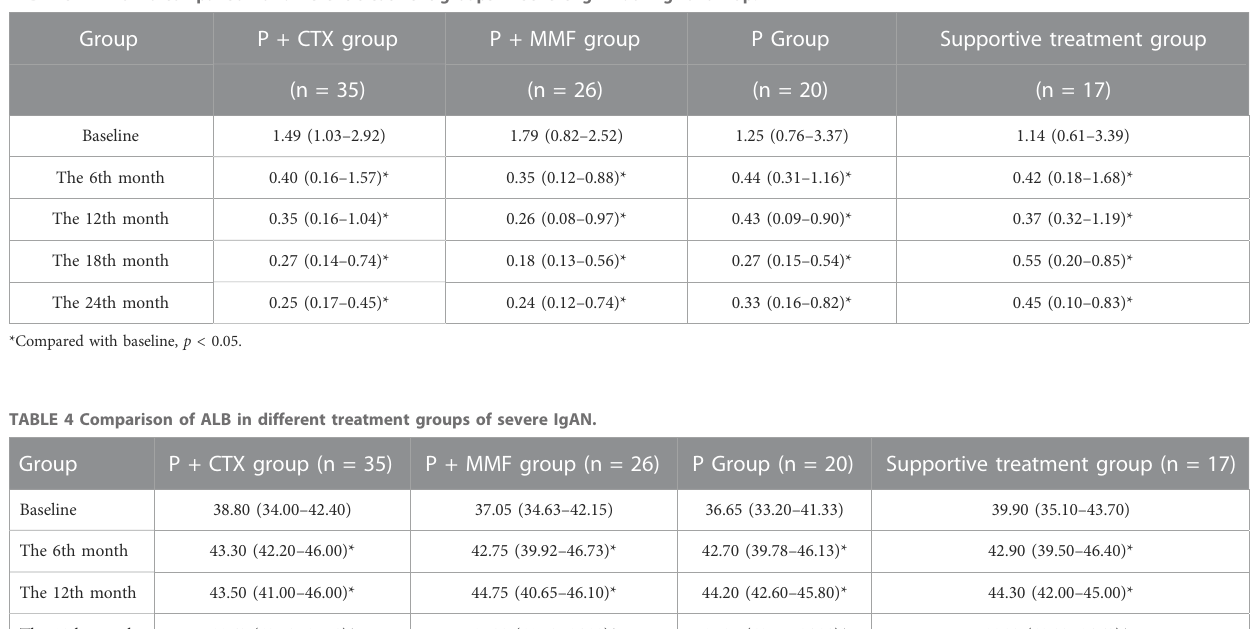
TABLE 3 24 h-UPro comparison of different treatment groups in severe IgAN during follow-up.